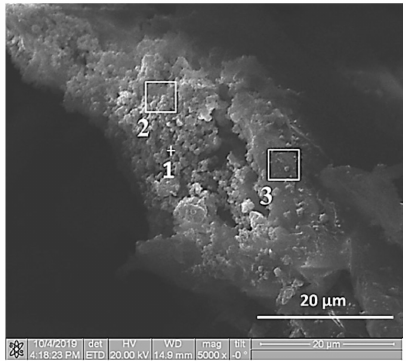
Figure2. SEMimagesofAl-Ti-Bpowderparticlesafter900splanetarymillingatdi ff erentmagnifications: ( a ) 140 × ; ( b ) 1400 × ; ( c ) 10000 × .